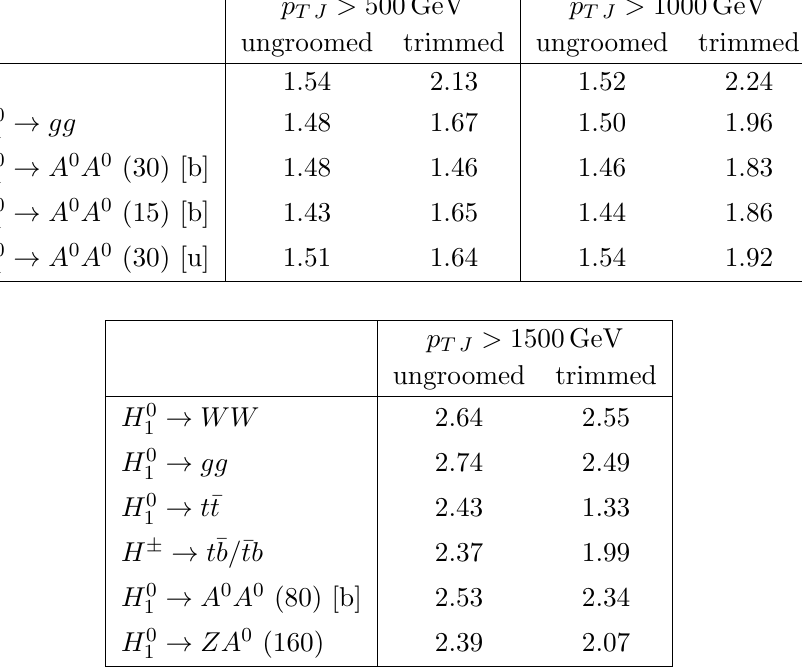
[65 ; 105] GeV (top), 2